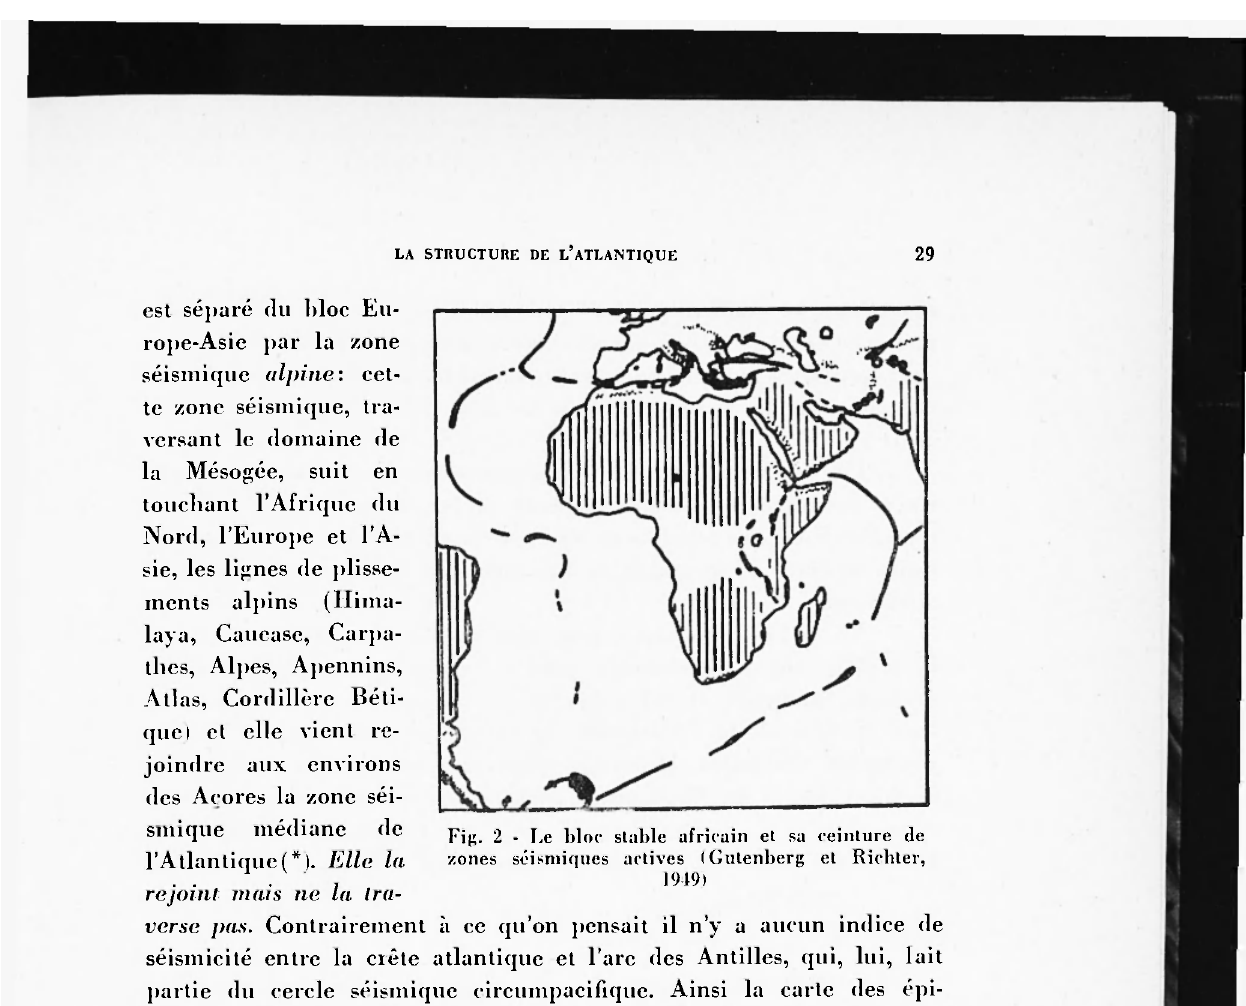
Fig. 2 - Le bloc stable africain et sa ceinture de zones séismiques actives (Gutenberg et